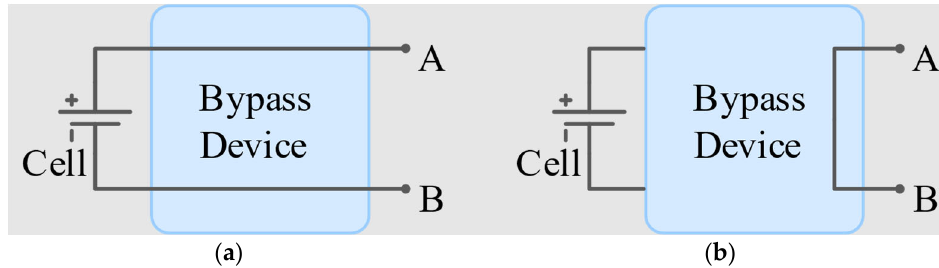
Figure 3. The operation mode of the switching device: ( a ) inserted; ( b ) bypassed.